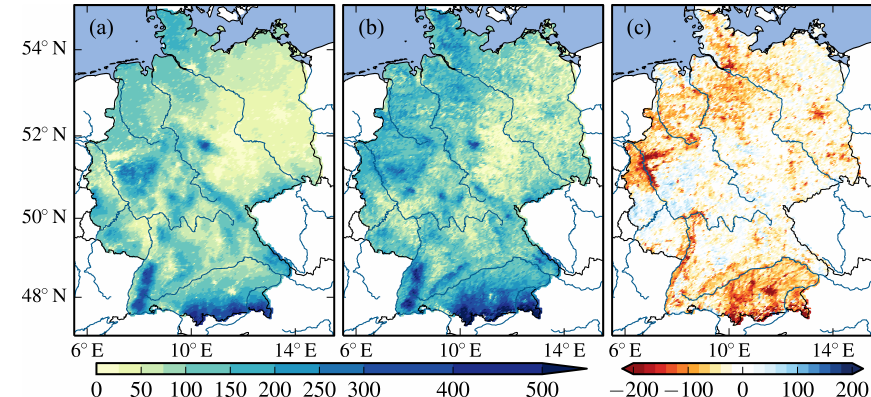
Figure 8. Comparison of mean annual groundwater recharge ( R ) modeled with (a) mHM and from (b) the Hydrologic Atlas of Germany (Federal Ministry for the Environment Nature Conservation Building and Nuclear Safety, 2003; Neumann and Wycisk, 2003). Panel (c) shows the difference (a–b) between the two datasets. The units are [mma − 1 ] for all